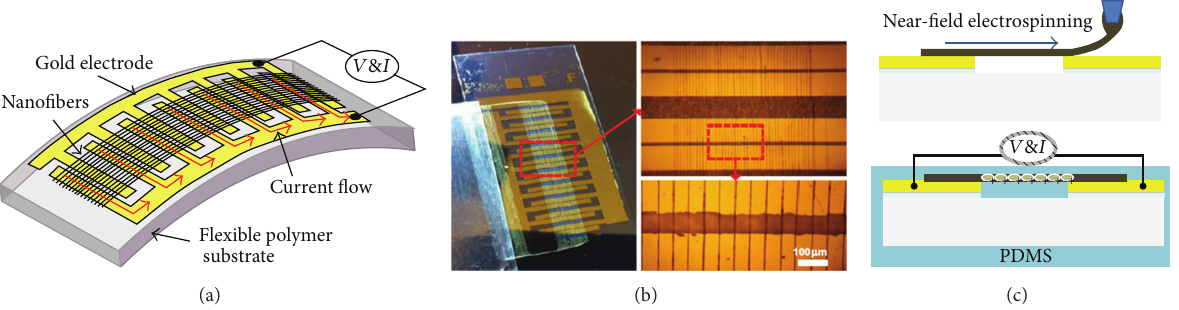
Figure 11: Schematic diagram (a), photograph (b), and fabrication process (c) of a PVDF LING. (Reproduced from [46] with the permission from Elsevier.)